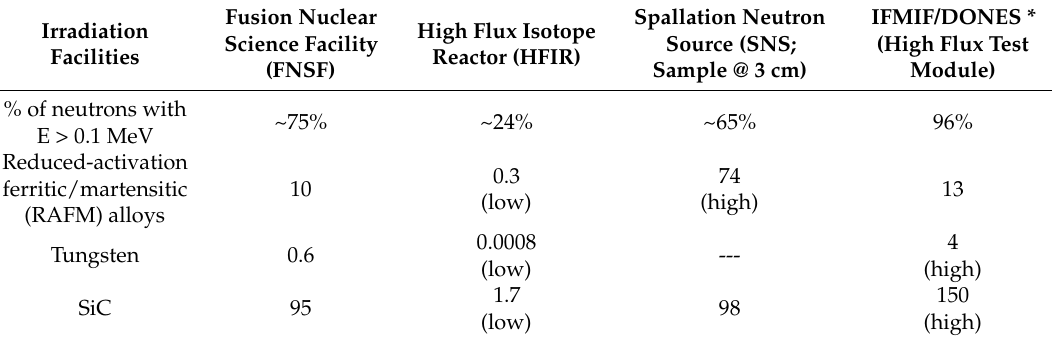
Table 1. He to dpa ratio for testing in existing and proposed neutron